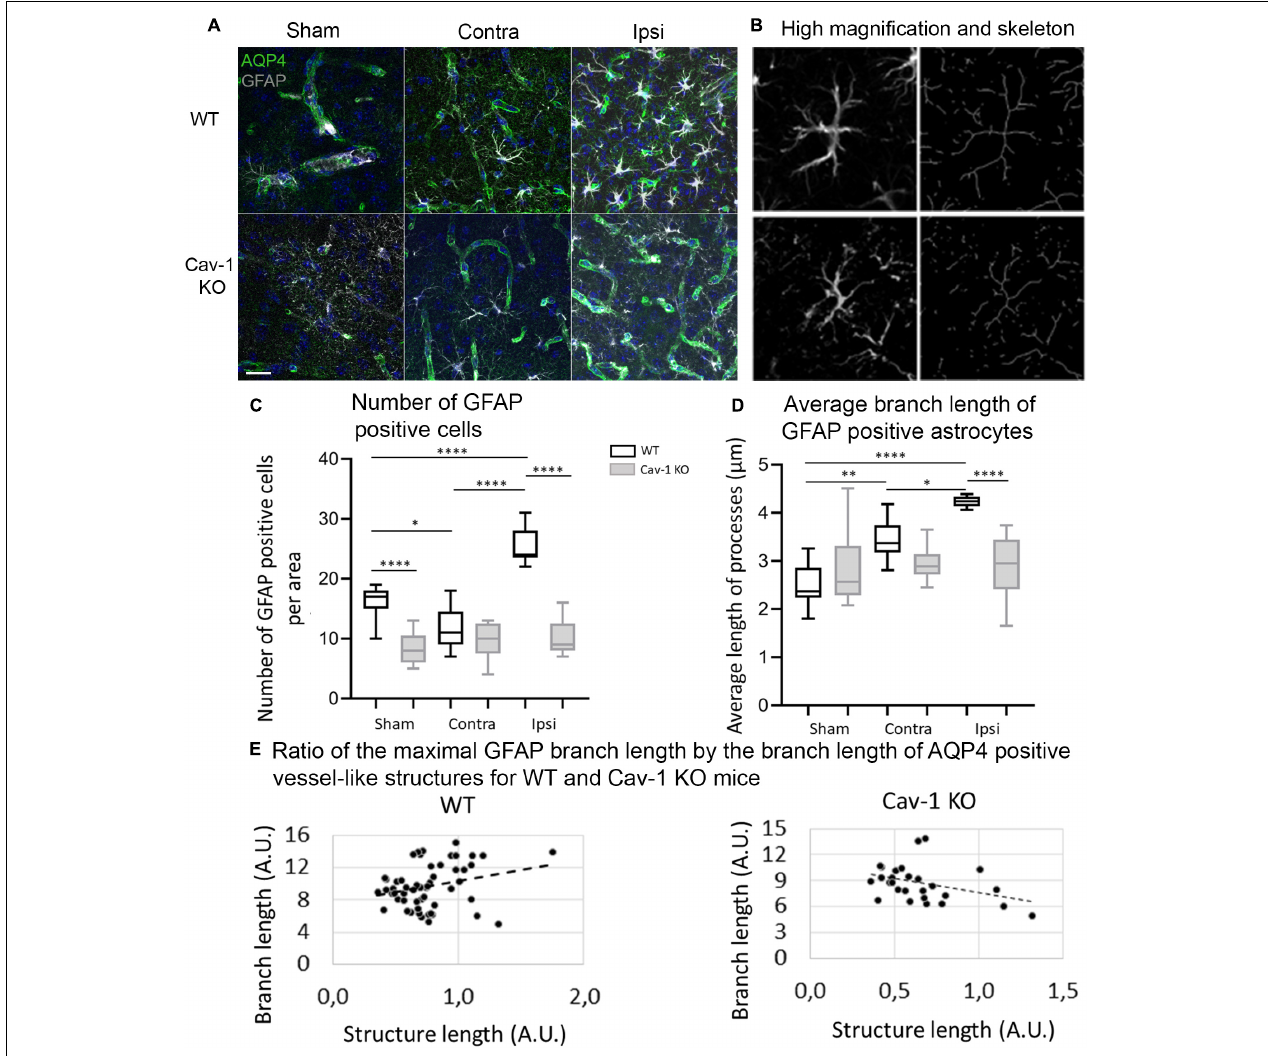
FIGURE 3 | (A) Immunofluorescence staining with AQP4 (green) and GFAP (gray) in WT and Cav-1 KO mice at 72 h post-MCAO (63 × magnification). AQP4 co-localized with GFAP-positive astrocyte end-feet. Scale bar = 20 µ m. (B) Single-channel confocal microscopy ROIs obtained from 40 × magnification images, illustrating the overview of a GFAP-positive astrocyte morphology and its skeletonization. (C) Number of GFAP-positive reactive astrocytes. WT-Sham compared to WT-Ipsi: 95% CI: [ − 13.42 to − 5.027], p < 0.0001, WT-Sham compared to WT-Contra: 95% CI [0.4716 to 8.862], p = 0.0212, WT-Sham compared to KO-Sham: 95% CI: [3.805 to 12.20], p < 0.0001, WT-Ipsi compared to WT-Contra: 95% CI [ − 18.08 to − 9.694], p < 0.0001, and WT-Ipsi compared to KO-Ipsi: 95% CI [10.92 to 19.31], p < 0.0001. (D) Average branch length of GFAP-positive astrocytes. WT-Sham compared to WT-Ipsi: 95% CI [ − 2.455 to − 1.005], p < 0.0001, WT-Sham compared to WT-Contra: 95% CI [ − 1.648 to − 0.1988], p = 0.0054, WT-Ipsi compared to WT-Contra: 95% CI: [ − 1.531 to − 0.08208], p = 0.0210, and WT-Ipsi compared to KO-Ipsi: 95% CI [0.5799 to 2.029], p < 0.0001. Comparisons were carried out by one-way ANOVA with Tukey’s multiple comparisons